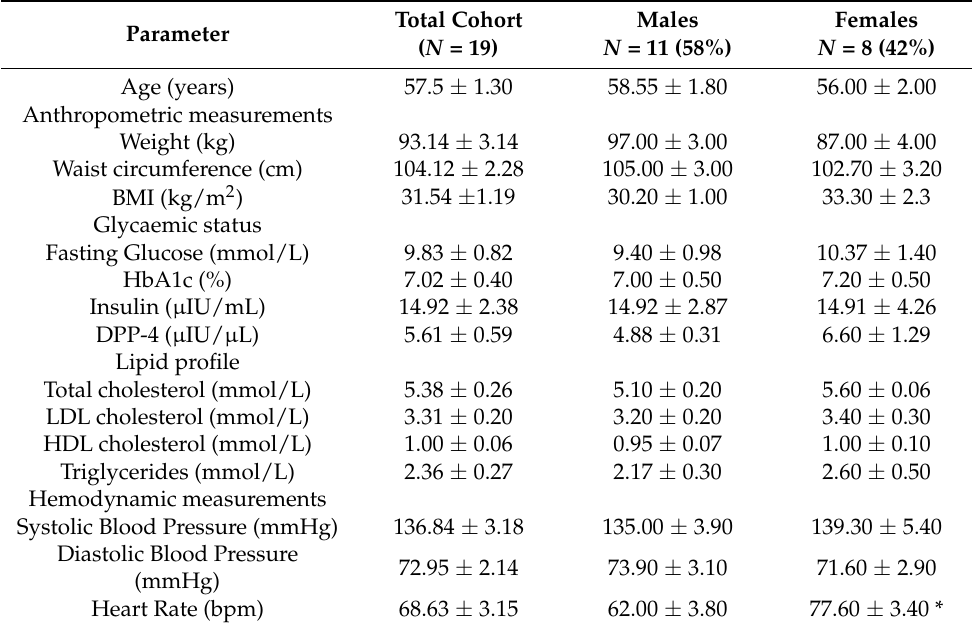
Table 2. Descriptive characteristics of the study participants at baseline.